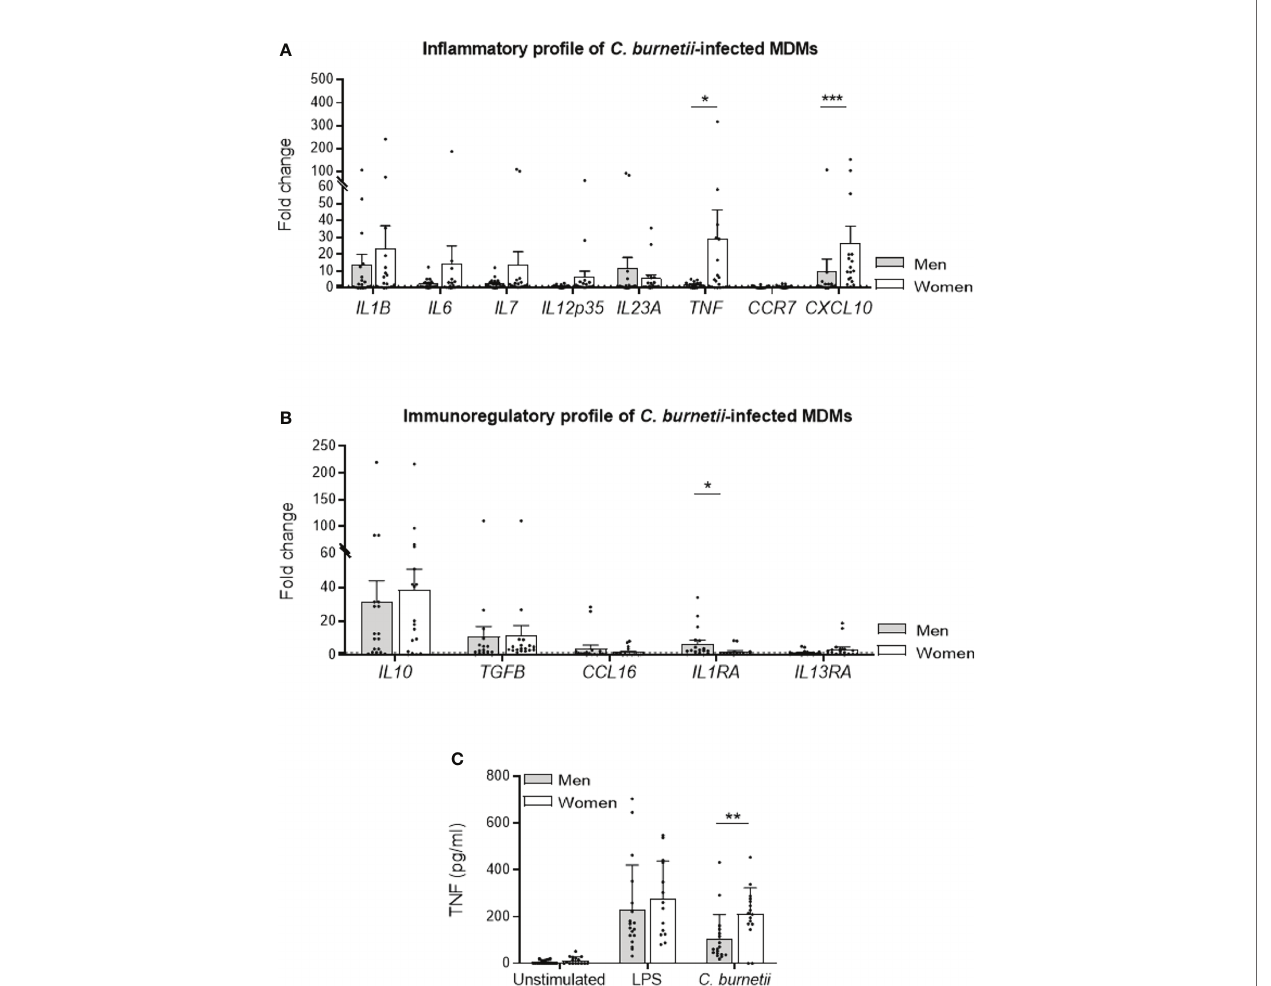
FIGURE 2 | M 1 /M 2 polarization pro fi leof C. burnetii -infected MDMs. MDMsfromhealthydonors frommales (n=18)and females (n=18)were infectedwith C. burnetii (50 bacteriaper cell)for 6 hours and transcriptional responses were assessed byqRT-PCR andconstant amount oftotalDNA. The expression of MDM (A) M 1 and (B) M 2 polarization genes was investigated byqRT-PCR and expressedas fold change relative to unstimulated cells was calculated. Geneexpression was considered modulated when the fold change was ≥ 1.5 (indicated bythe dottedline). (C) The release ofTNF byMDMs, infected or not by C. burnetii (50 bacteria per cell) or stimulated with 1 µg/mL LPS for 24 hours, was determined byimmunoassays. Data for men (in grey) and female(in white) represent mean ± standard errorofthe mean (duplicate was performed for each individual). Statisticalanalyses were performed using Mann-Whitney U test (men vs. women). * p ≤ 0.05, ** p ≤ 0.01 and *** p ≤